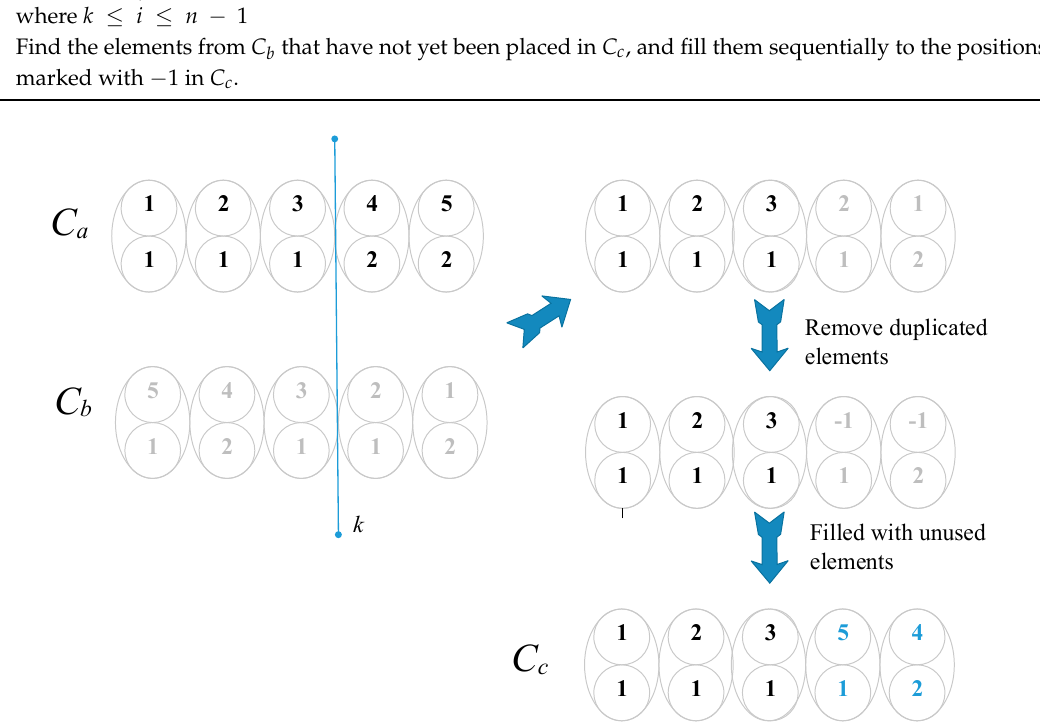
Figure 4. An illustration of the crossover operation.